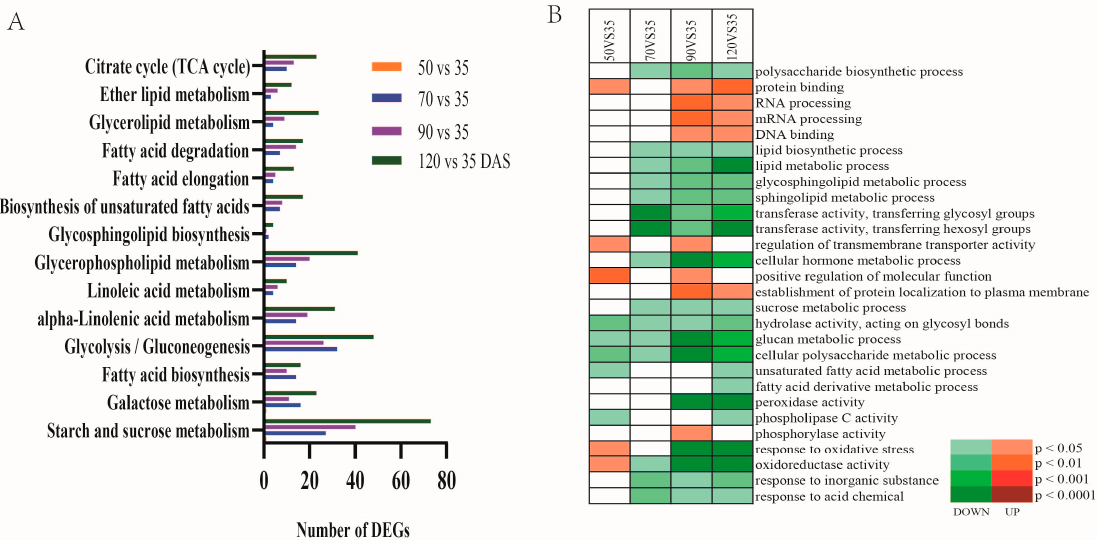
Figure 5. Function annotation of unigenes during tuber development. ( A ) Functional enrichment analyses using the Kyoto Encyclopedia of Genes and Genomes (KEGG) pathways. ( B ) Functional enrichment analyses using GO (Gene Ontology) analysis. Heatmap statistics showing significantly ( p < 0.05) enriched Gene Ontology categories among the differential expression genes of different development stages. Color gradients toward red indicate high statistic significant GO of up-regulated DEG, Color gradients toward green indicate high statistic significant GO of down-regulated DEG, and blank indicates no statistical significance.